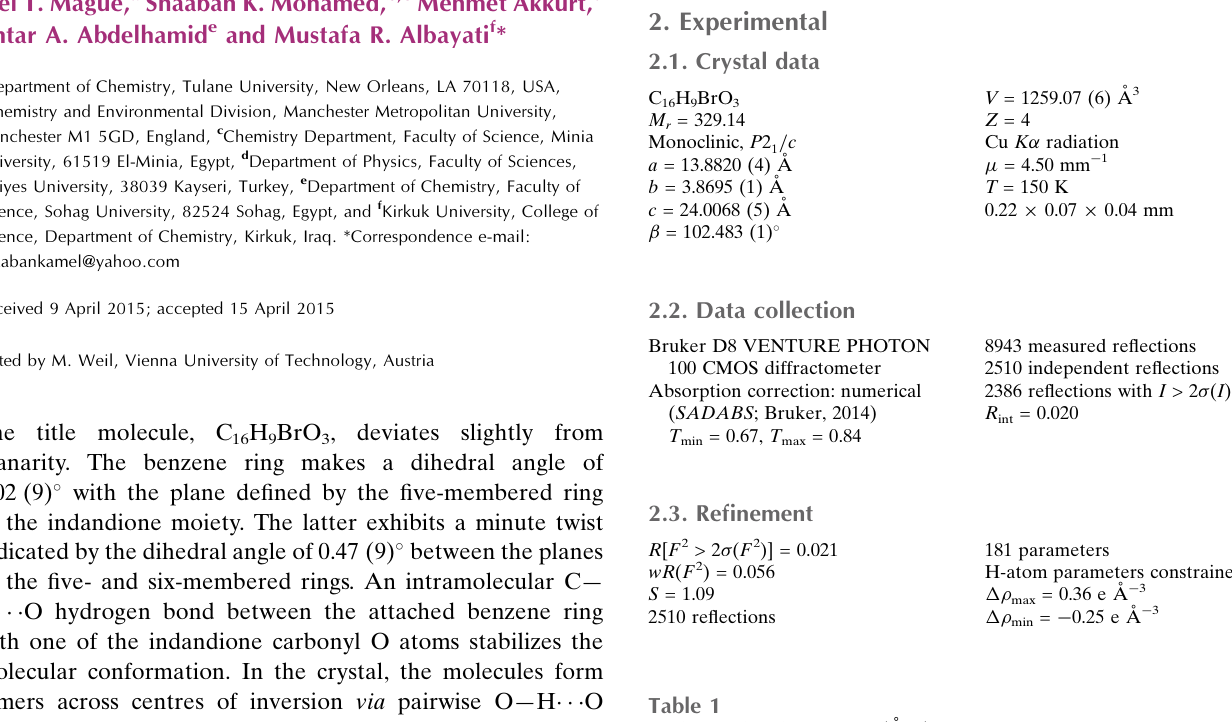
Hydrogen-bond geometry (A˚ , (cid:2)